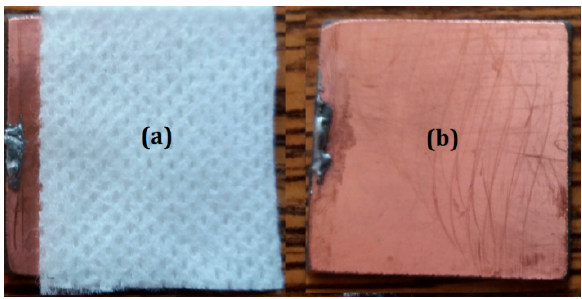
Figure 5. ( a ) Absorbent fabric (FT); ( b ) copper-plated plates (TCu).